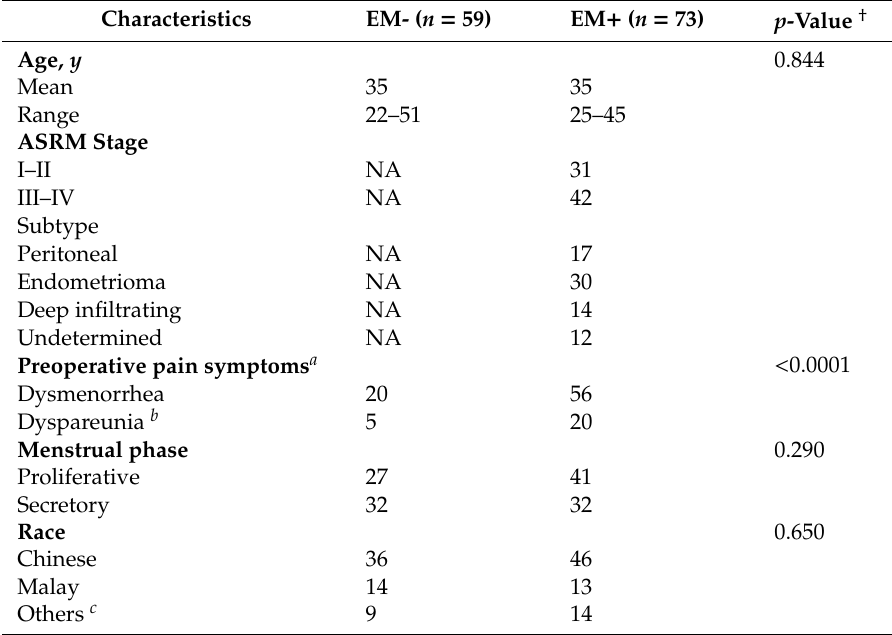
Table 1. Patient